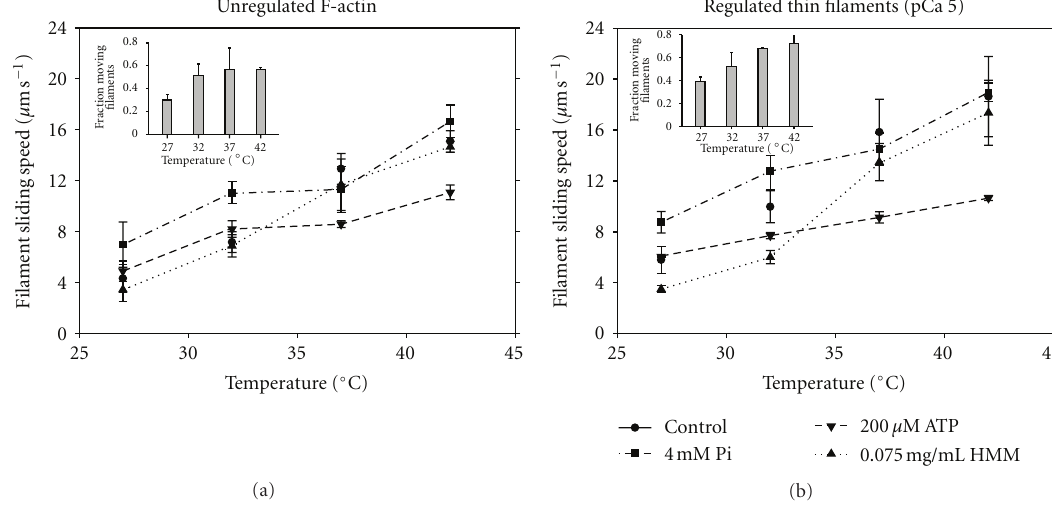
Figure 5: Influence of motility conditions on temperature dependence of filament sliding speeds for (a) unregulated F-actin and (b) regulated thin filaments (F-actin plus native cTn and α -Tm) at pCa 5. Points are the mean of means ± S.D. from 45–75 filaments in each of ≥ 3 individual flow cells and are plotted against steady-state temperature (27– 42 ◦ C) for four conditions. For this series of experiments only, control conditions (circles, solid lines) were [Pi] = ∼ 1 μ M (achieved by removal of contaminating Pi; Section 2); [ATP] = 2mM (bu ff ered by CP and CK; Section 2), and high ρ achieved by infusing 0.25 mg/mL [HMM] into the flow cell. Conditions were modified to test low ATP (200 μ M ATP; inverted triangles, short dashed lines); high Pi (4mM Pi; squares, long dash dotted lines); or low ρ (0.075 mg/mL HMM; triangles, dash dotted line). Lines were drawn to connect the points. Insets: temperature dependence of fraction of filaments moving under low ρ condition plotted for (a) unregulated F-actin and (b) regulated thin filaments at pCa 5. Note that the fraction of regulated thin filaments, but not unregulated F-actin, increases continuously over this temperature